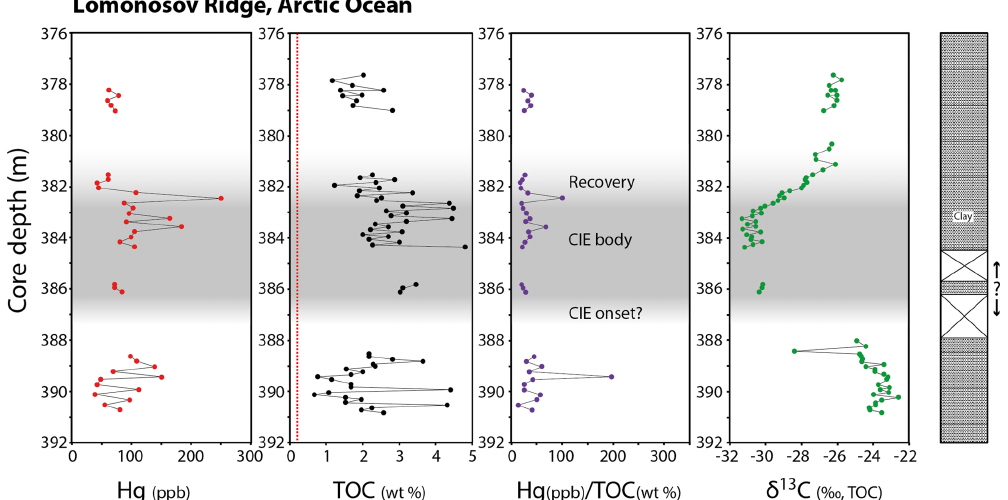
Figure 7. Mercury, TOC, Hg / TOC, and δ 13 C TOC data from the 302-4A core collected from the Lomonosov Ridge as part of the IODP Arctic Coring Expedition (ACEX). The colouring scheme is the same as in Fig. 3. Incomplete core recovery is marked by crossed squares, with the middle fragment occurring at some unknown interval somewhere between the two sections of complete core recovery. The onset of the CIE is missing. The grey shaded area shows the approximate CIE body and recovery phases. Carbon isotope measurements are from Sluijs et al. (2006). The stratigraphic log is from Backman et al. (2004). The red dashed line in the TOC graph denotes the recommended threshold for TOC concentrations to report Hg / TOC values (Grasby et al., 2016).